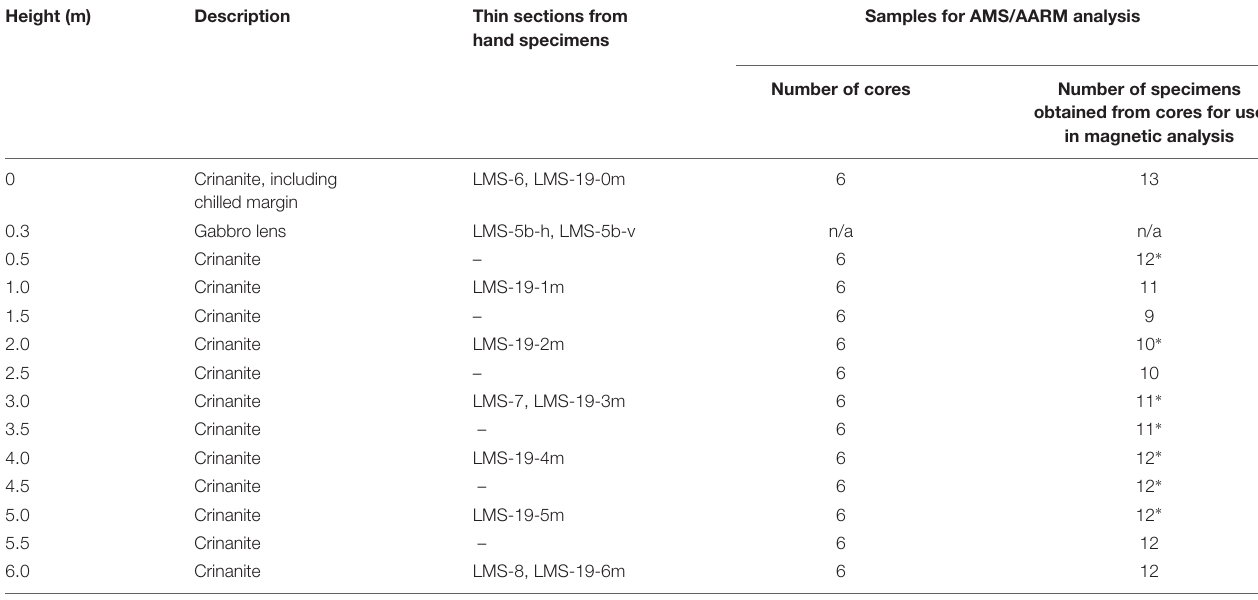
TABLE 2 | Table showing the location and heights of thin sections for petrology and the number of cores collected for magnetic anisotropy studies. Height (m) Description Thin sections from hand